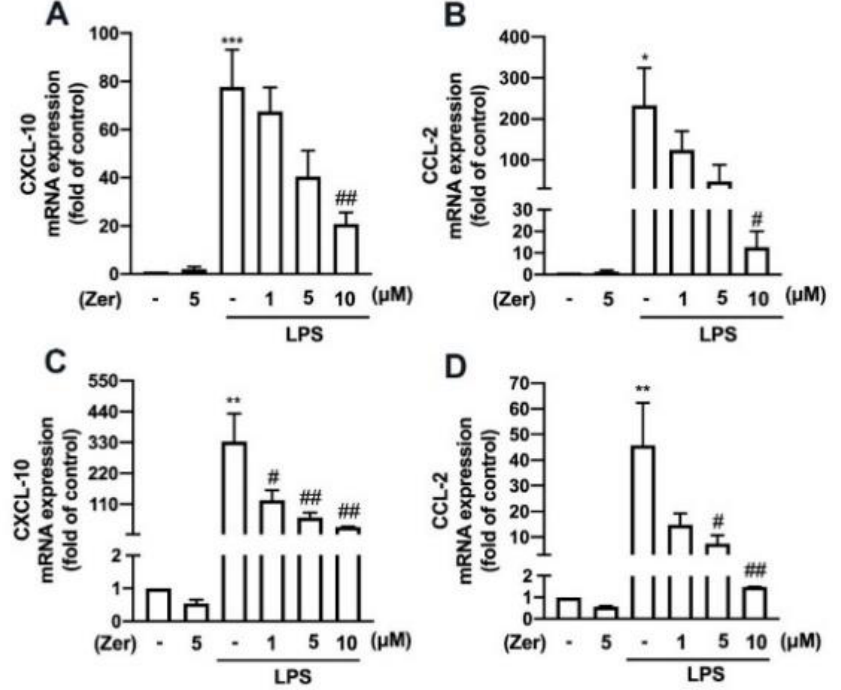
Figure 4. The expression of proinflammatory mediators in macrophages and microglia in response to zerumbone. RAW264.7 ( A , B ) and IMG ( C , D ) cells were supplemented with different concentrations of zerumbone (1, 5, or 10 µ M) for 30 min and then activated by LPS (50 ng/mL) for another 6 h. CXCL-10 ( A , C ) and CCL-2 ( B , D ) mRNA expression was analyzed using real-time PCR and normalized to β -actin. Data are presented as the mean ± SEM ( n = 3). * p < 0.05, ** p < 0.01, *** p < 0.005 compared with the control group. # p < 0.05, ## p < 0.01 compared with the LPS alone.